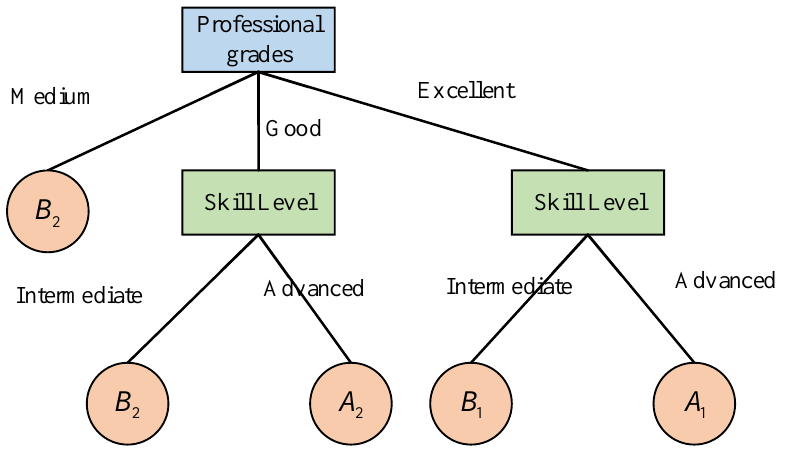
Figure 1. Decision tree generated at f ( s ) = 0.6.